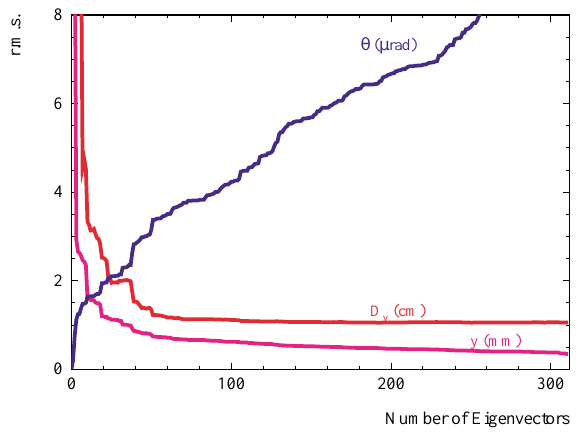
FIG. 6. (Color) Predicted rms of the vertical orbit ( y ), dispersion ( D y ), and corrector kicks ( u ) for a bare orbit correction as a function of the number of used eigenvectors (for a (cid:1) 0.2 and b (cid:1) 0